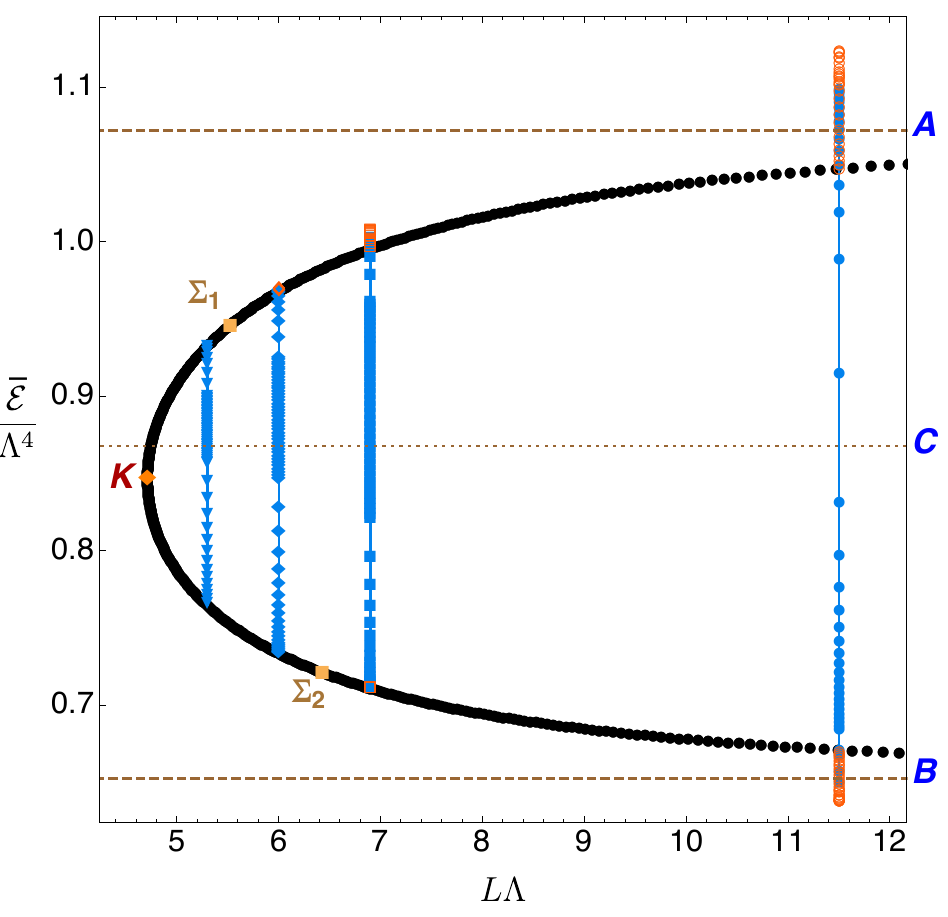
Figure 16 . Same stability diagram as in figure 8 with the inclusion of some lumpy-brane lines that bifurcate from the GL merger curve. These lines have constant ˆ L given by { ˆ L H , ˆ L (cid:7) , ˆ L (cid:4) , ˆ L • } ’ { 5 . 299674 , 6 . 004224 , 6 . 900924 , 11 . 501849 } . Solid blue markers (empty orange markers), no matter (cid:12) their shape, indicate positive (negative) ∆ˆ σ . Note that some orange circles are on top of (cid:12) sameˆ L, ˆ ρ some blue disks. This describes the region around the cusps of figure 17 and